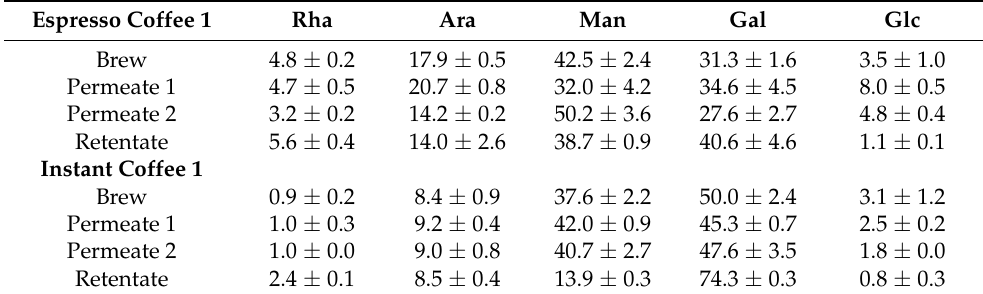
Table 4. Sugars composition (mol%) for espresso coffee 1 brew, instant coffee 1 brew, ultrafiltered Permeates 1 and 2, and